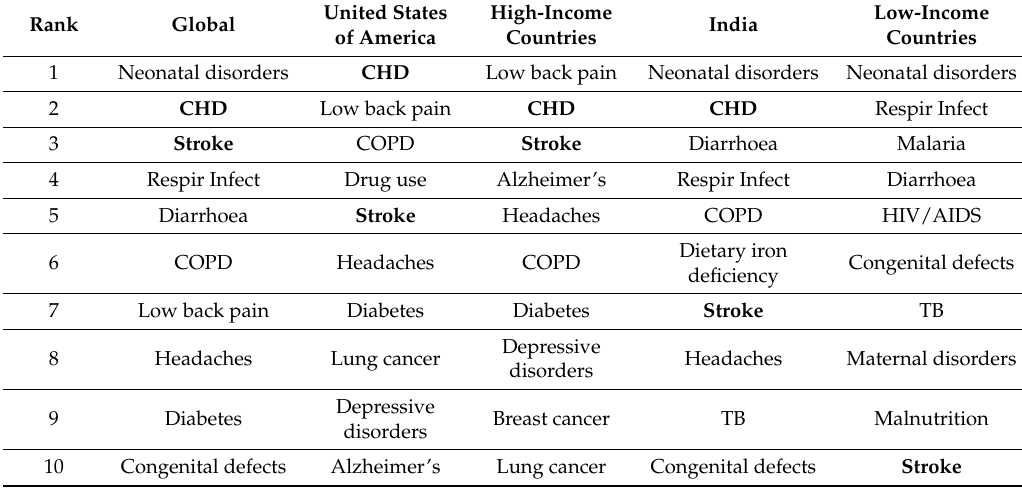
Table 2. The 10 most common causes of disability-adjusted life-years lost in women, globally and in selected countries and regions,